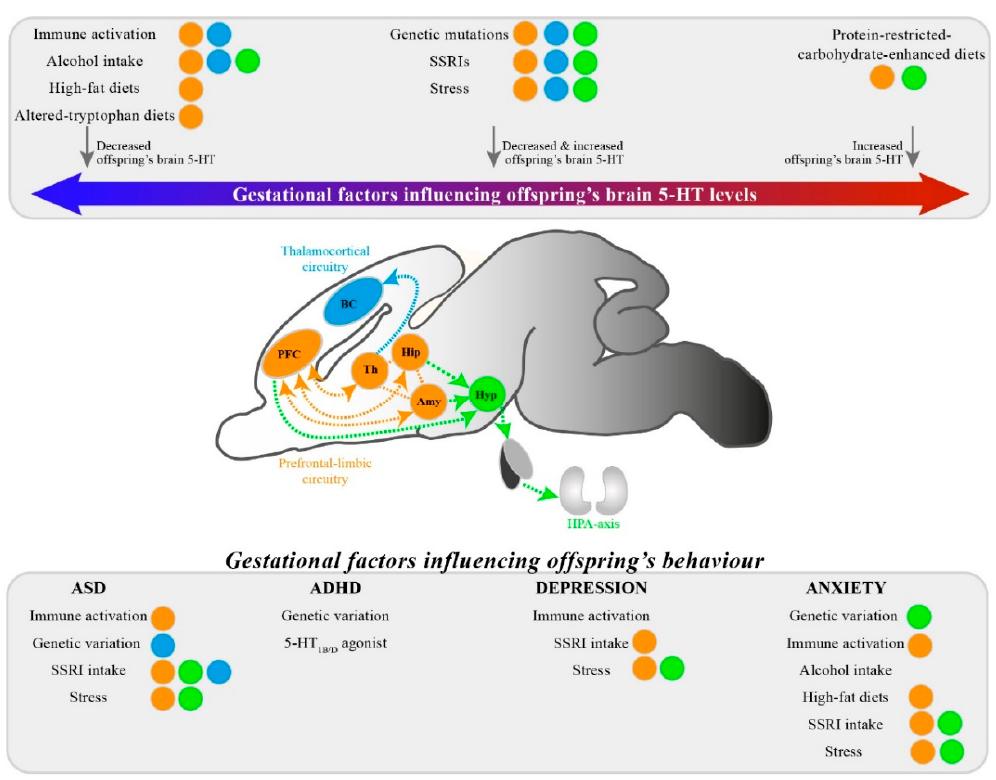
Figure 3. Schematic overview of the e ff ects of gestational factors on the o ff spring’s 5-HT-ergic influence on brain circuits maturation and the resulting aberrant behavior. Gestational factors (i.e., maternal 5-HT-ergic genotype, 5-HT-related diets, stress exposure, 5-HT-related medication intake, and immune activation) decrease (arrow blue, left) or increase (arrow red, right) the o ff spring’s brain 5-HT levels. The gestational factors in the middle (purple) have been found to increase as well as decrease brain 5-HT levels in the o ff spring. Gestational-factor-induced alterations in the formation and function of the prefrontal-limbic circuitry, thalamocortical circuitry, and the HPA-axis are depicted via orange, blue, and green dots, respectively. We mention which gestational factor has been associated to the highlighted neuropsychiatric disorders of ASD, ADHD, depression, and anxiety. Furthermore, where possible, direct links have been depicted between gestational-factor-induced 5-HT-ergic-related changes within one of the three brain circuits and a neuropsychiatric disorder. 5-HT: serotonin; ASD: autism spectrum disorders; ADHD: attention deficit hyperactivity disorder; HPA: hypothalamo-pituitary-adrenocortical; SSRIs: selective serotonin reuptake